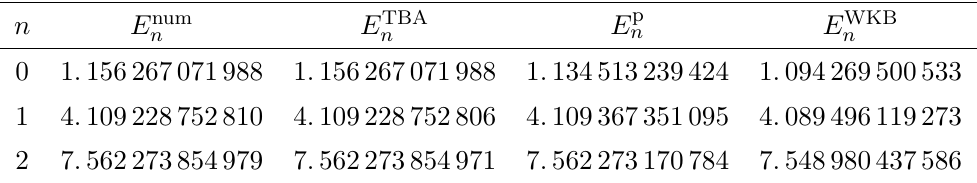
p (left) and (cid:5) np (right) for the